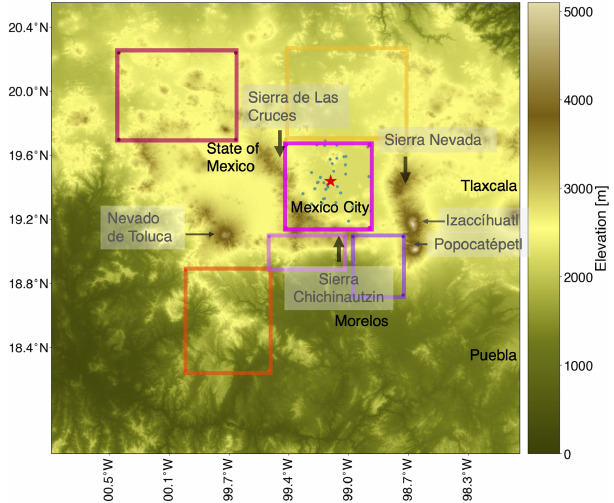
Figure 1. Elevation map of the Mexico City region. The red star denotes the center of Mexico City, and the pink box represents the area averaged to create monthly means used throughout the analy- sis. This area is referred to as “urban Mexico City”. Colored boxes represent regions of potential pollutant outflow further shown in Fig.